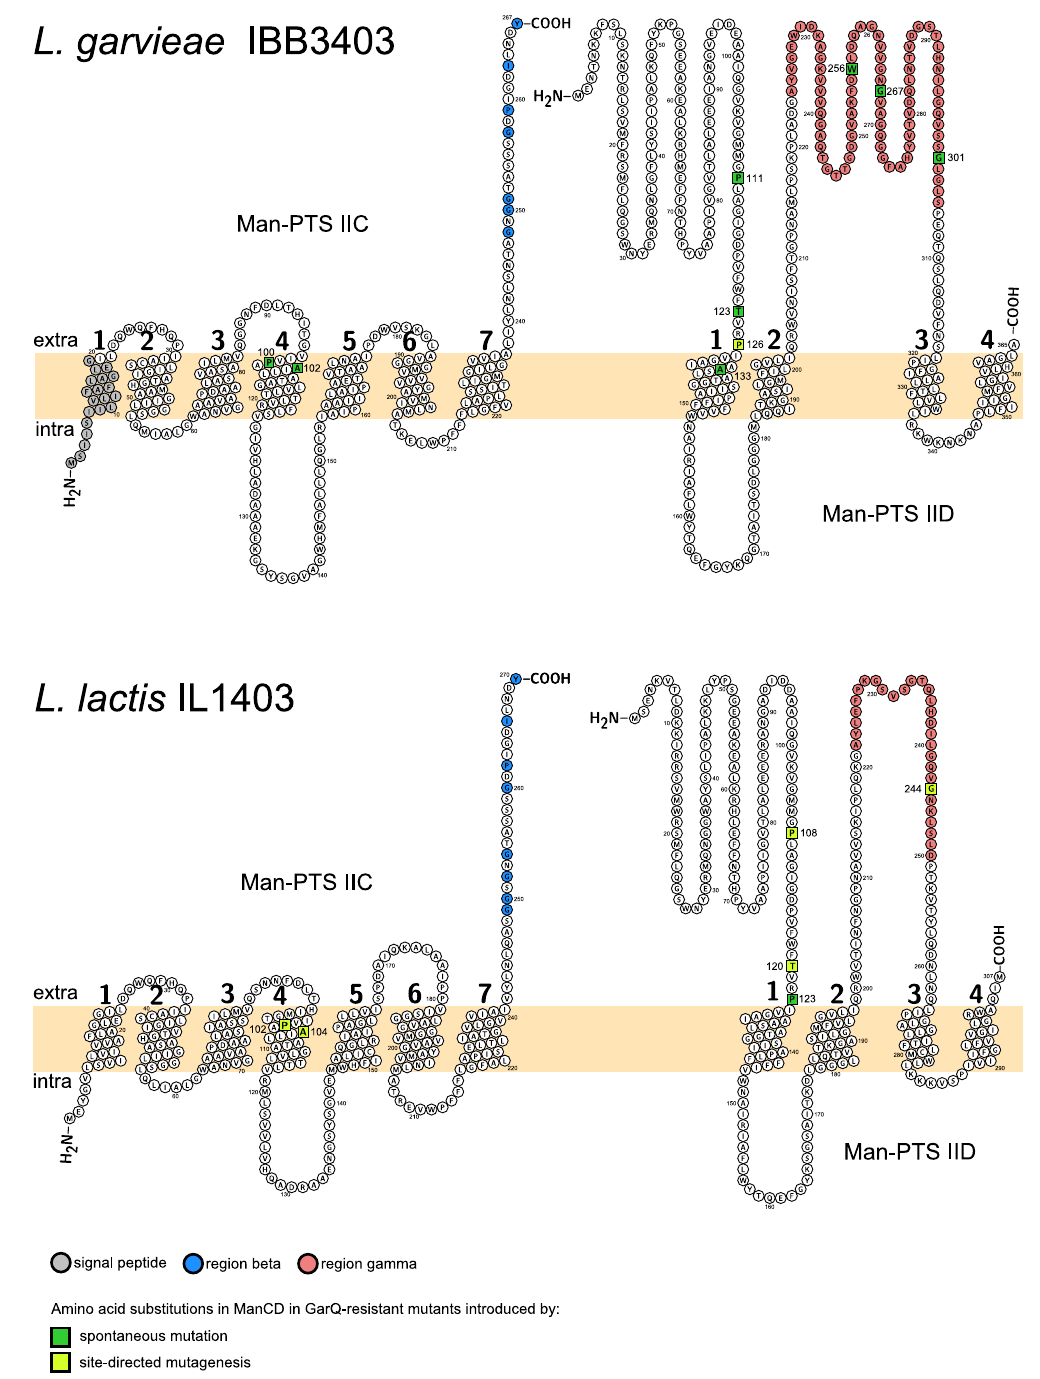
Figure 2. Predicted topology of the membrane Man-PTS subunits IIC and IID of L . garvieae IBB3403 and L . lactis